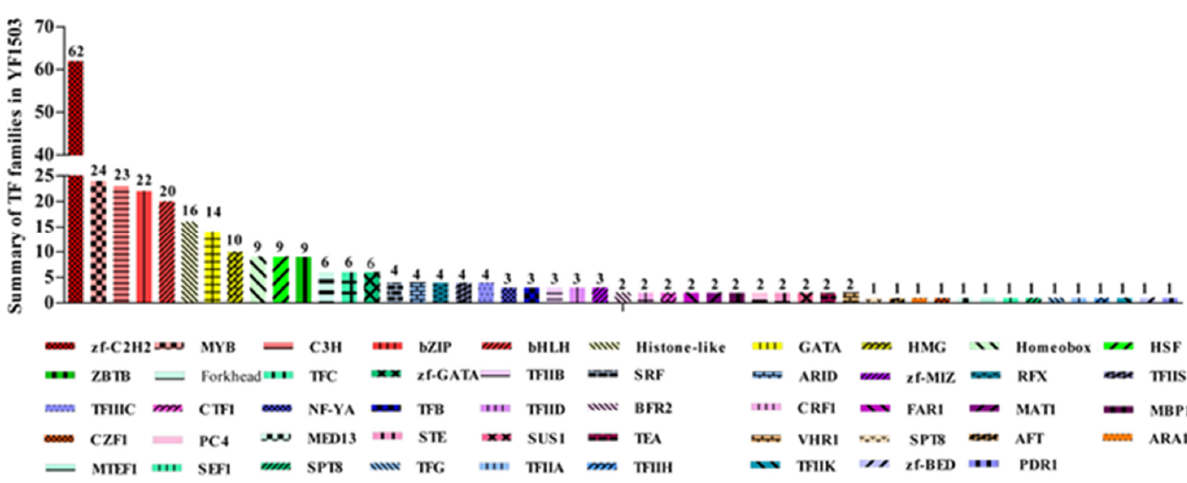
Figure 2 . Summary of the transcription factor genes in W. anomalus strain YF1503. The number of up-regulated (Up) or down-regulated (Down) genes for different fermentation periods.